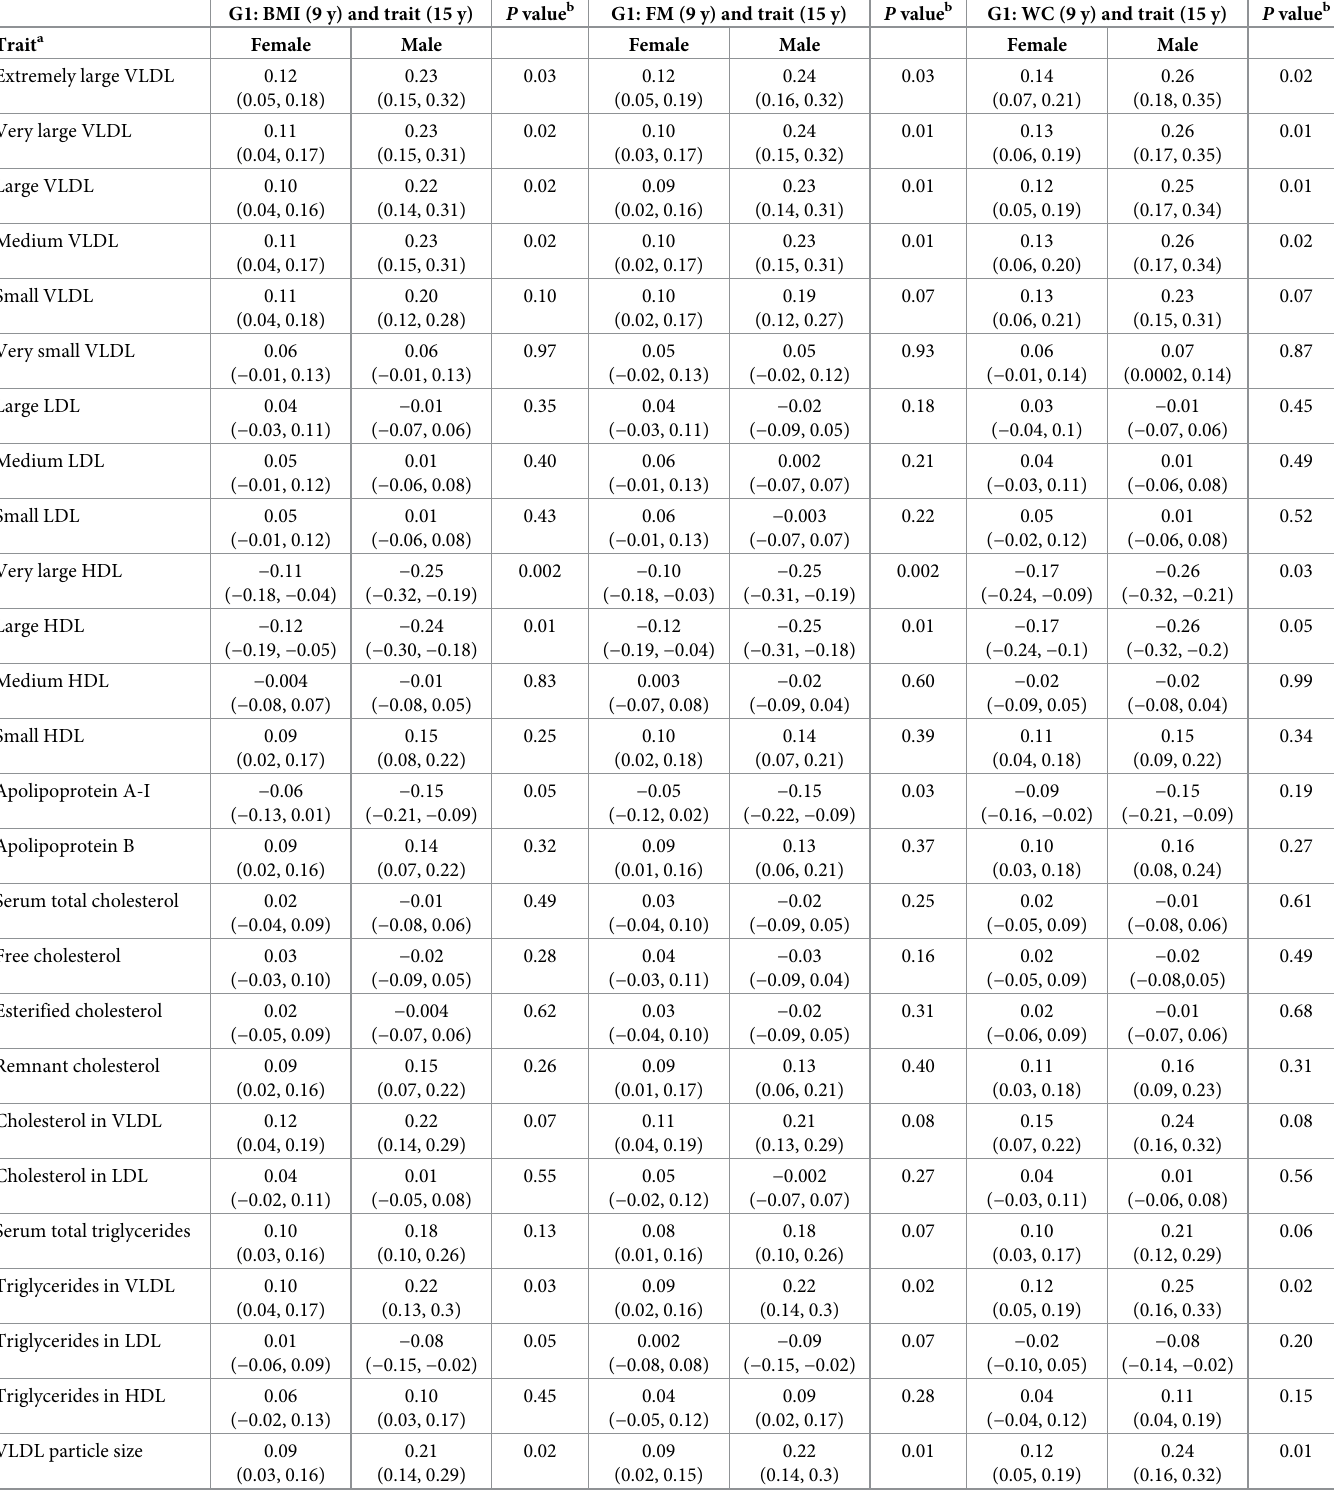
Table 2. Adjusted sex-specific associations of adiposity measures (per SD increase) at 9 y with standardised lipoprotein, cholesterol, triglyceride, and other trait concentrations at 15 y. G1: BMI (9 y) and trait (15